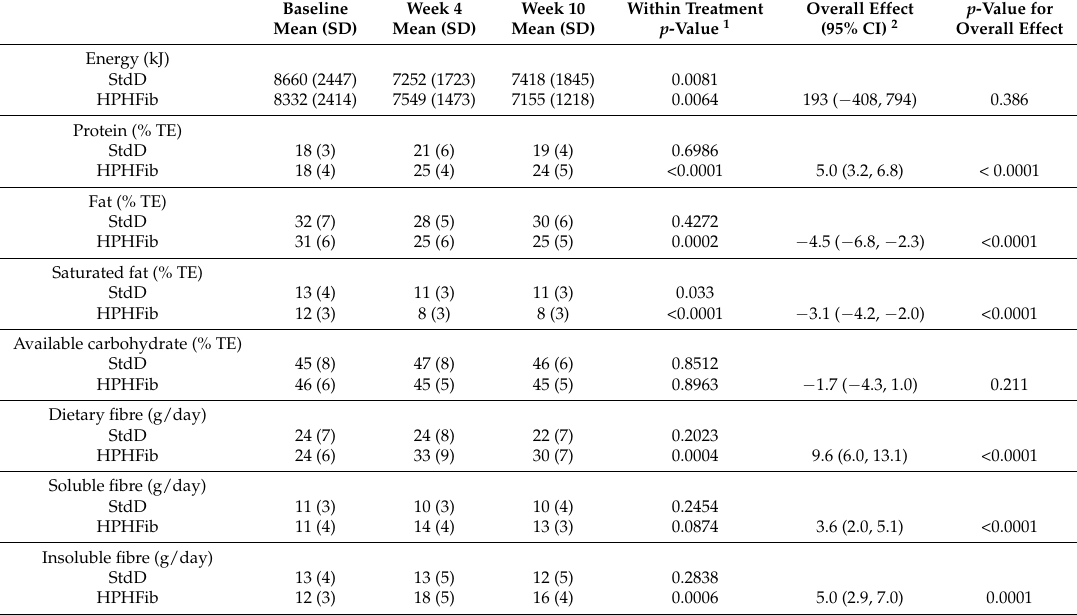
Table 2. Baseline, week 4 and week 10 measures for dietary variables for the standard diet (StdD) and HPHFib groups.